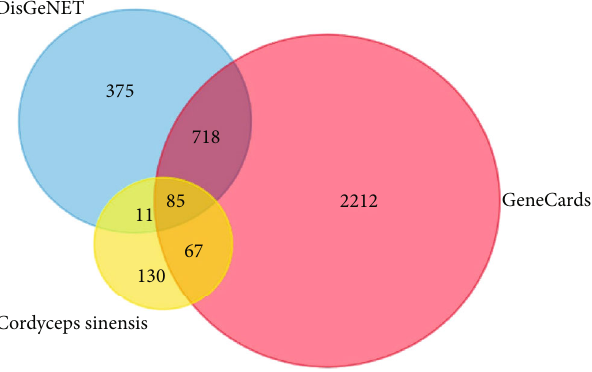
Figure 3: Overlapping target genes between DN and Cordyceps. Table 1: Essential information about Cordyceps active components. Mol